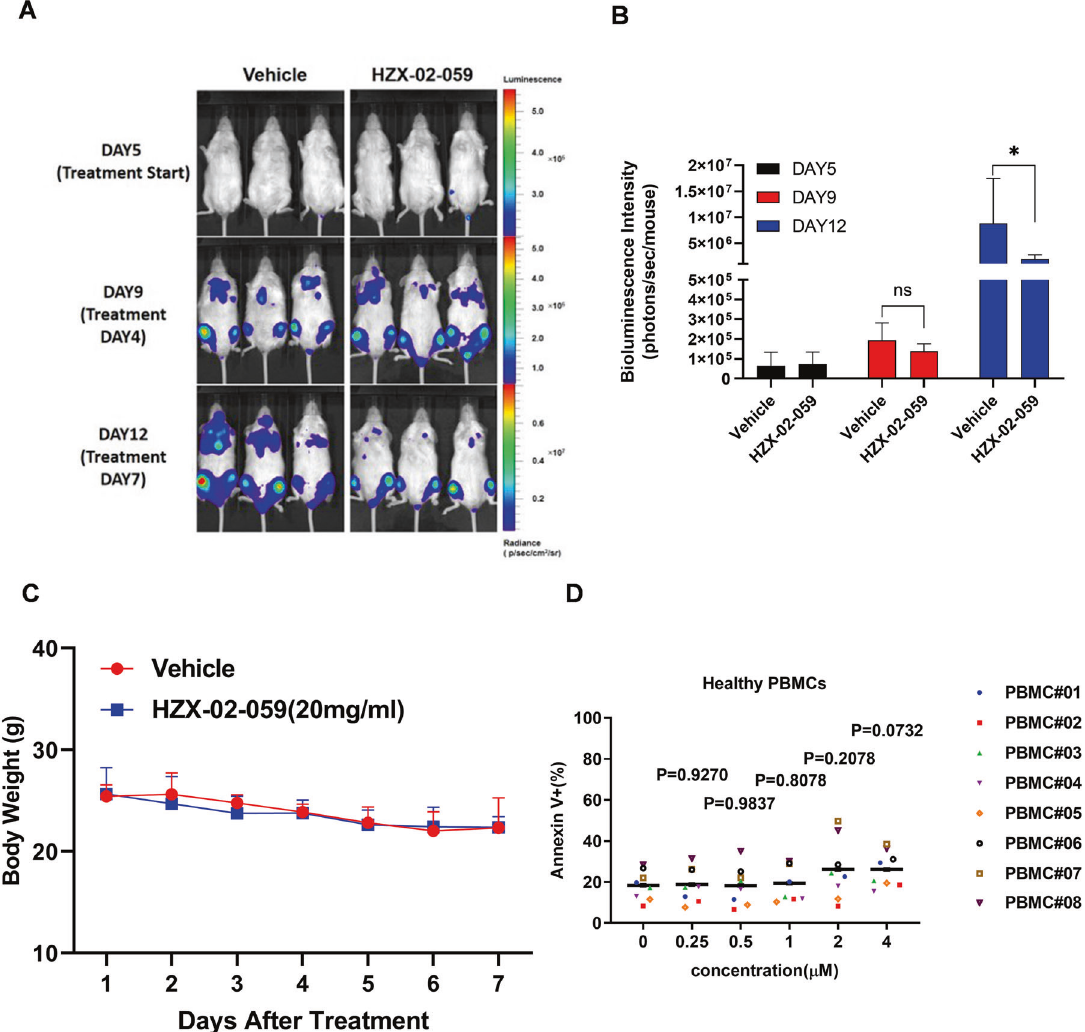
Fig. 6 HZX-02-059 suppresses growth of xenograft derived from DHL cells with a low systemic toxicity pro fi le. A Serial bioluminescence images of mice-bearing luciferase-labeled LR tumors were shown after treated with vehicle or HZX-02-059 (20 mg/kg) by intraperitoneal injection. B Quanti fi cation of bioluminescence emitted from the whole body of each mouse in Fig. 5A. C Body weight changes between vehicle and HZX-02-059 treatment. D HZX-02-059 treatment spared normal hematopoietic cells derived from peripheral blood of 9 healthy